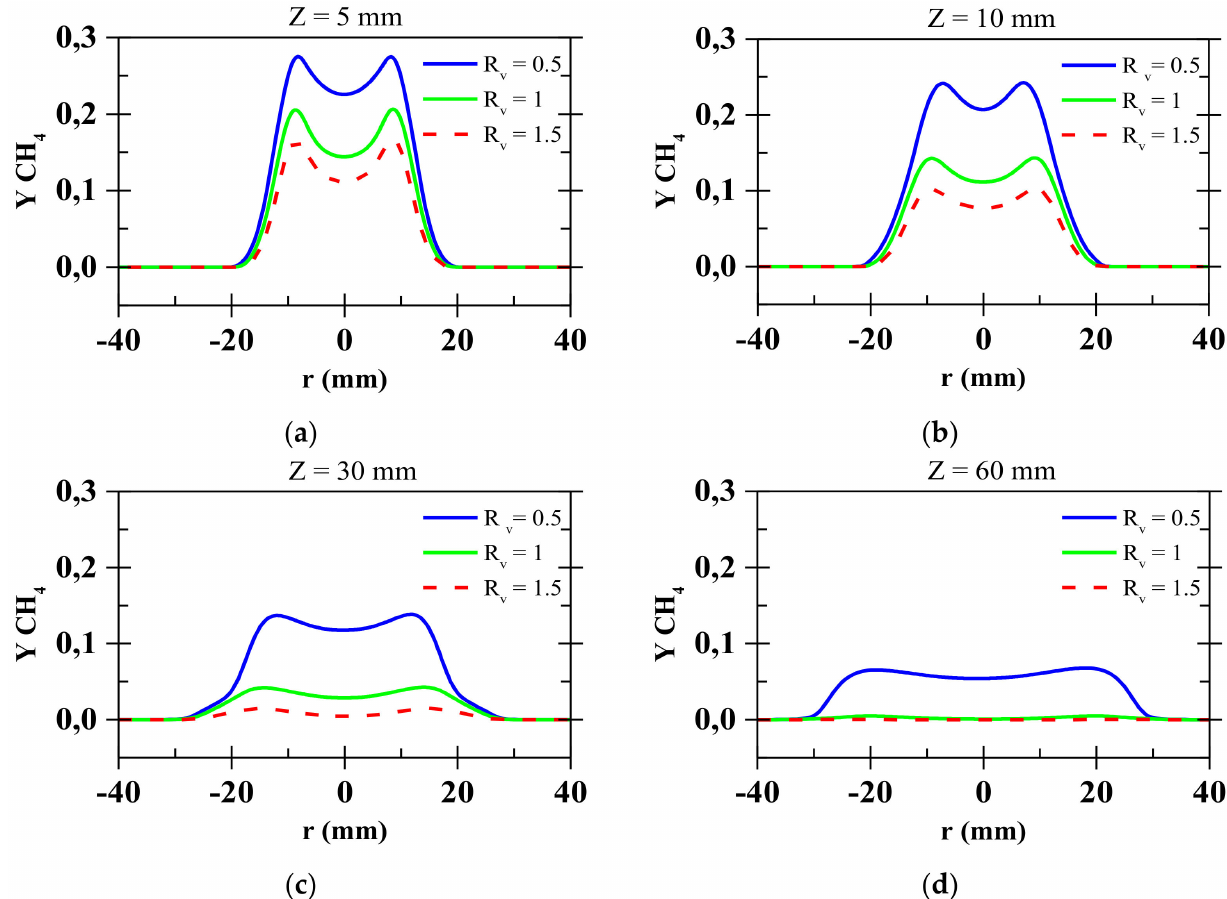
Figure 11. Radial profiles of the fuel mass fractions obtained for different velocity ratios and at four height